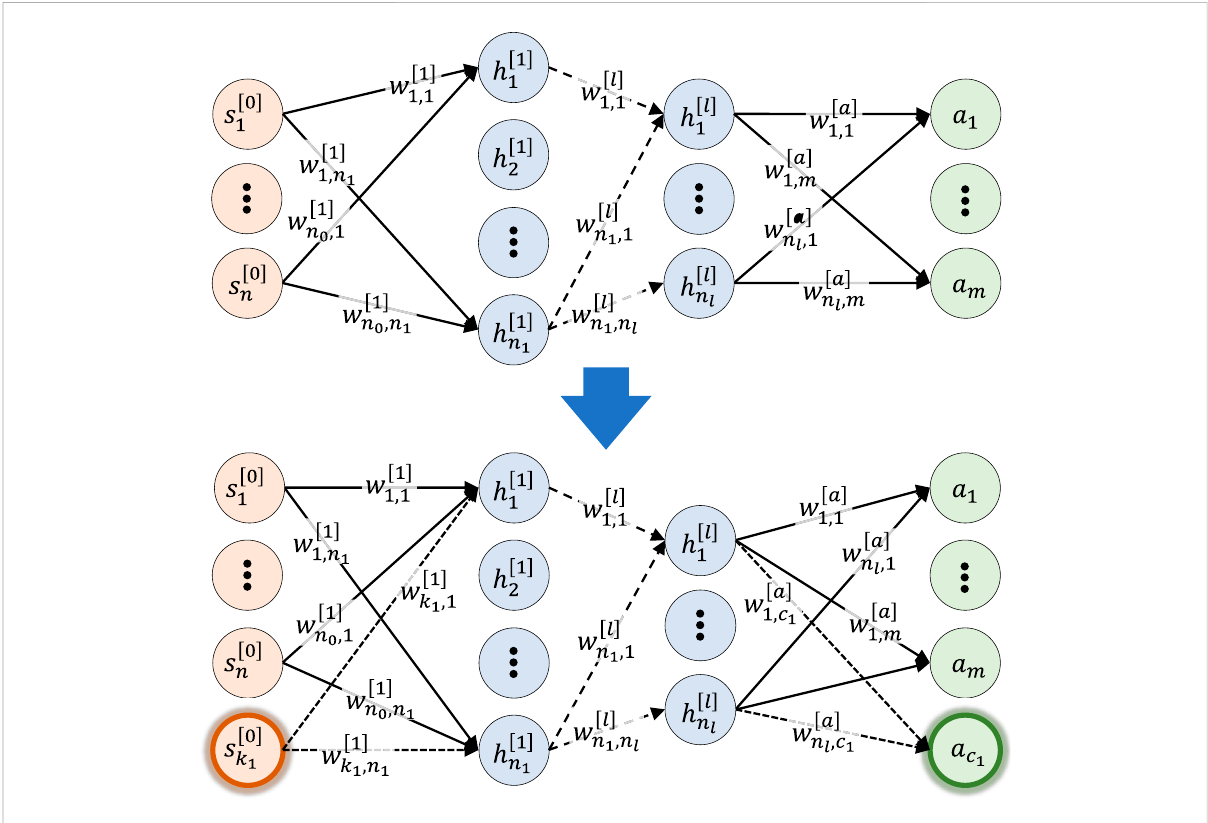
FIGURE 5 Augmented expert network. Top: Originally trained expert. Bottom: Augmented expert network. All neurons are fully connected including bias terms but omitted for